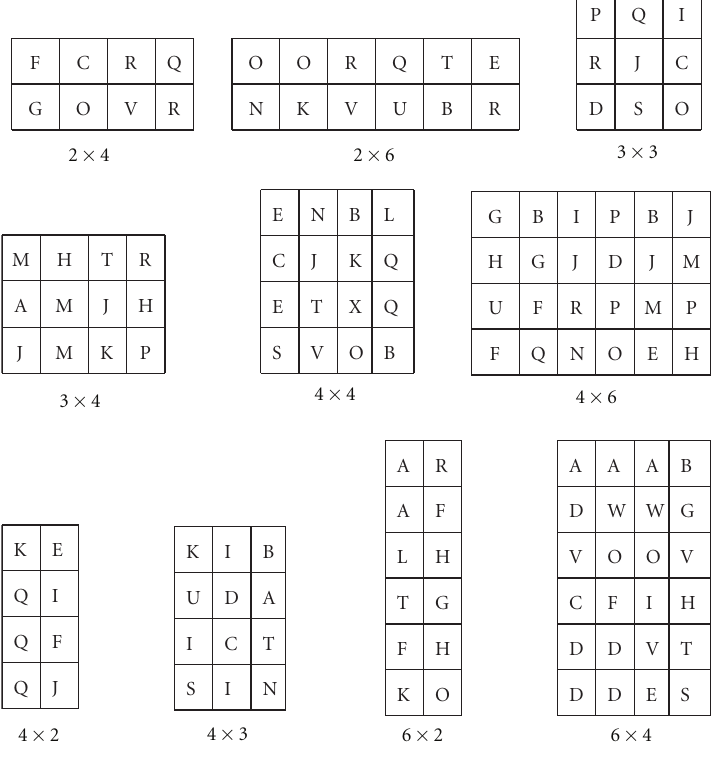
Figure 9: Shading matrixes for di ff erent array sizes with shading pattern of Figure 8.